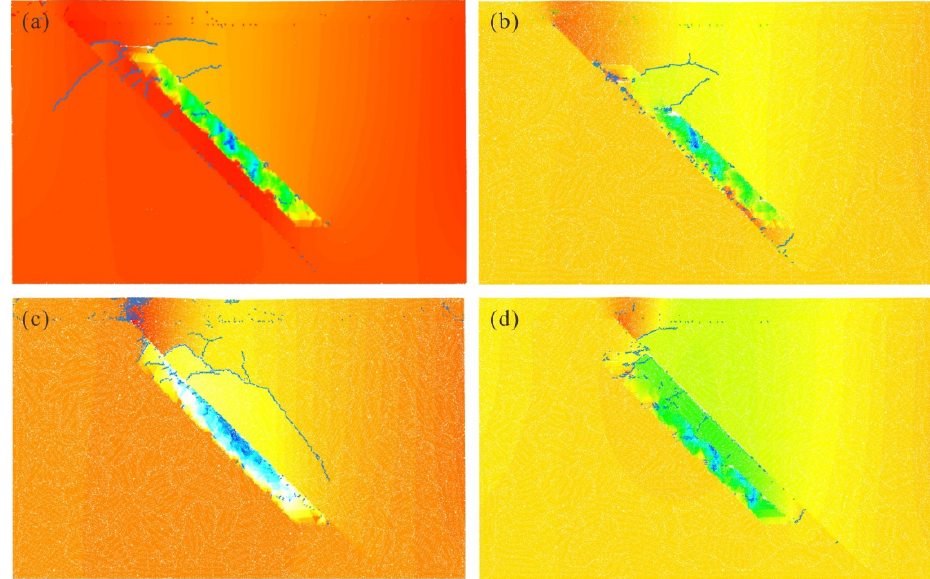
Figure 12. Failure modes for mining of an ore body under different fault locations. ( a ) Fault location at 30 m in the foot wall; ( b ) fault location at 5 m in the foot wall; ( c ) fault location at 5 m in the hanging wall; ( d ) fault location at 30 m in the hanging wall.